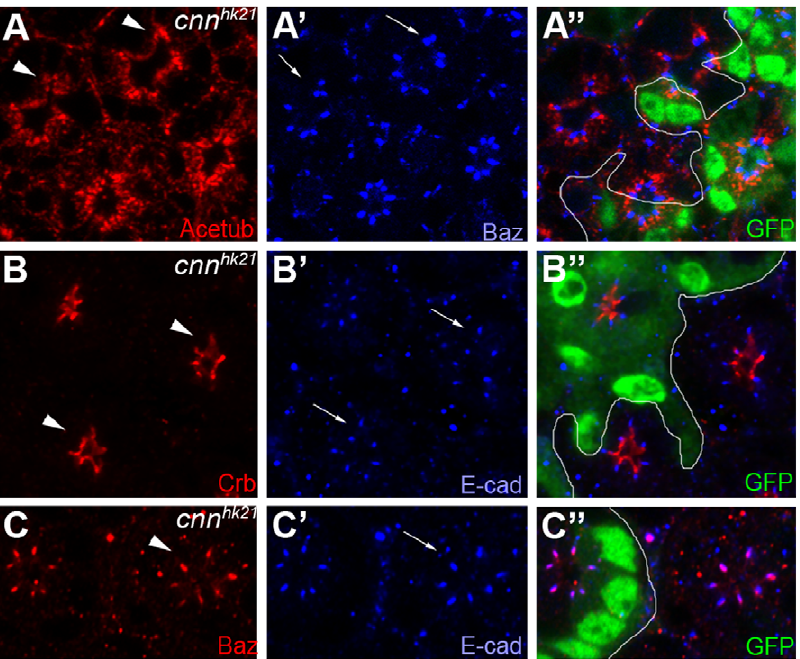
Figure 4. Cnn is essential for photoreceptor morphogenesis in the mid-stage developing pupal eyes. (A, B) Pupal eyes (50% pupal developmental stage) with cnn hk21 null mutant clones marked by the absence of the GFP (green). (A) Acetylated tubulin (Acetub, red, A) and Baz (blue, A 9 ) were mislocalized from apical to basal in the absence of the Cnn (absence of the GFP, A 0 ). Ectopic mispositioned acetylated tubulins (A) and Baz (A 9 ) are indicated by arrowheads (A) and arrows (A 9 ), respectively. (B) Crb (red, arrowheads, B) and E-cad (blue, arrows, B 9 ) were mislocalized from apical to basal in the absence of the Cnn (absence of the GFP, B 0 ). (C) Baz (red, arrowhead, C) and E-cad (blue, arrow, C 9 ) were co-mislocalized from apical to basal in the absence of the Cnn (absence of the GFP, B 9